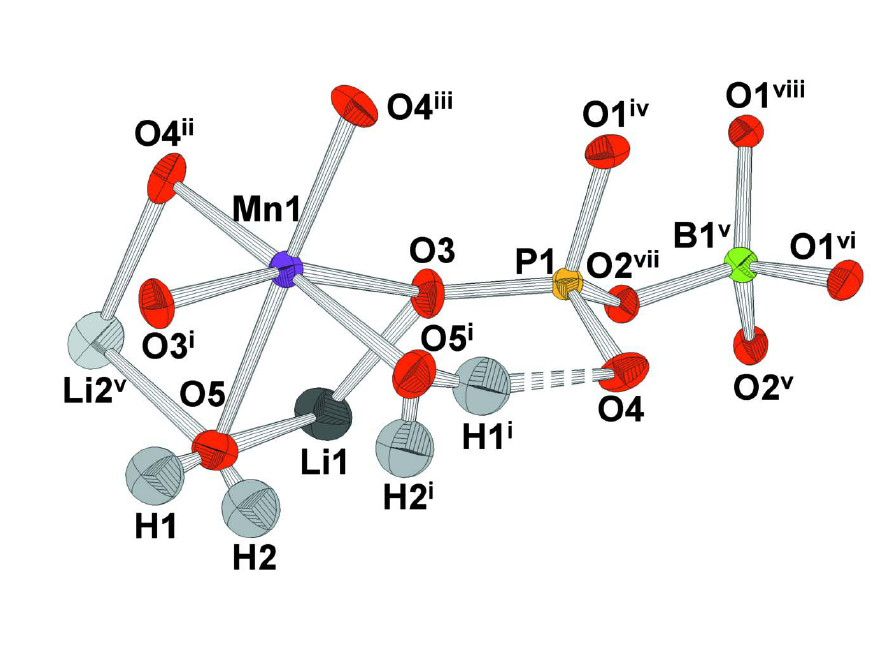
Coordination environment of Mn, B, and P atoms, with displacement ellipsoids drawn at the 50% probability level (symmetry codes: (i) -x+y, y, 1/2-z; (ii) 1-x, 1-x+y, 1/3-z; (iii) y,1-x+y, 1/6+z; (iv) 1-y,1-x, 1/6-z; (v) x-y, x,-1/6+z;